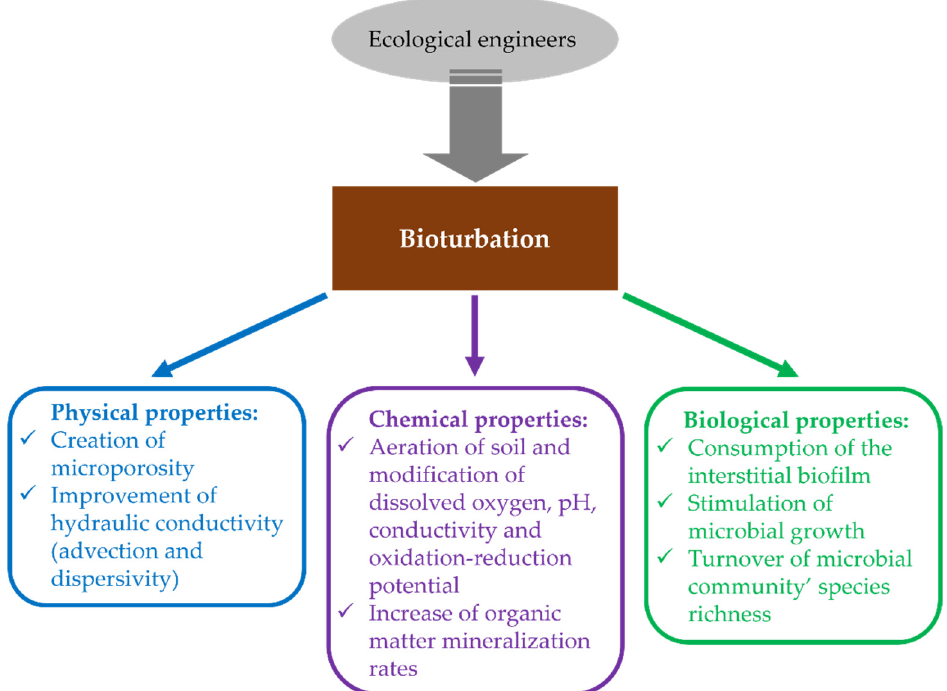
Figure 1. Biodiversity influence on porous medium properties.